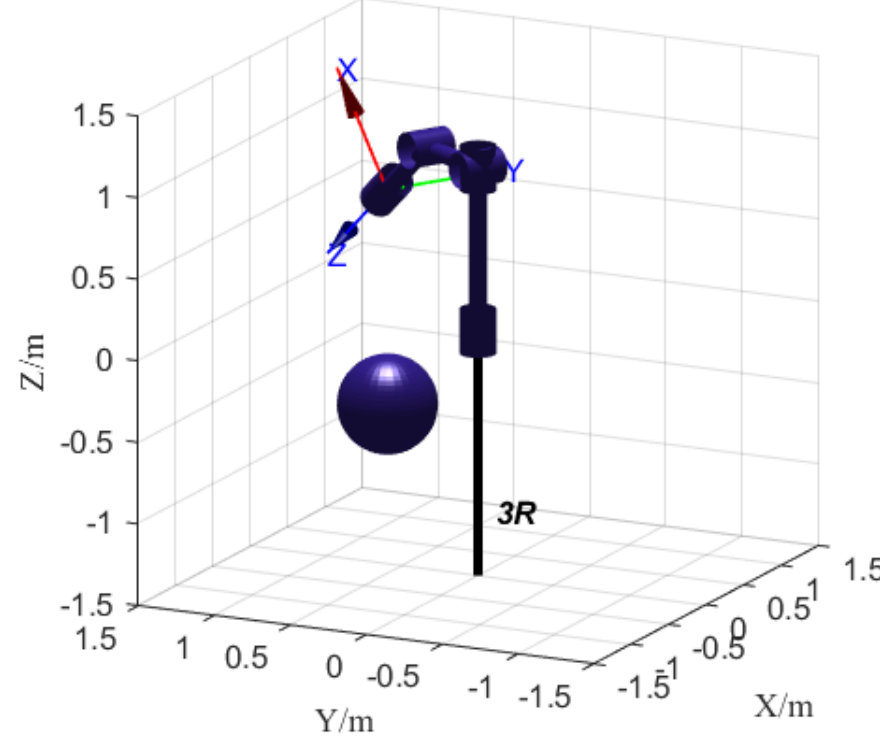
Figure 5. The simplified model of the 3-DOF manipulator. Table 2. DH parameter of the manipulator.